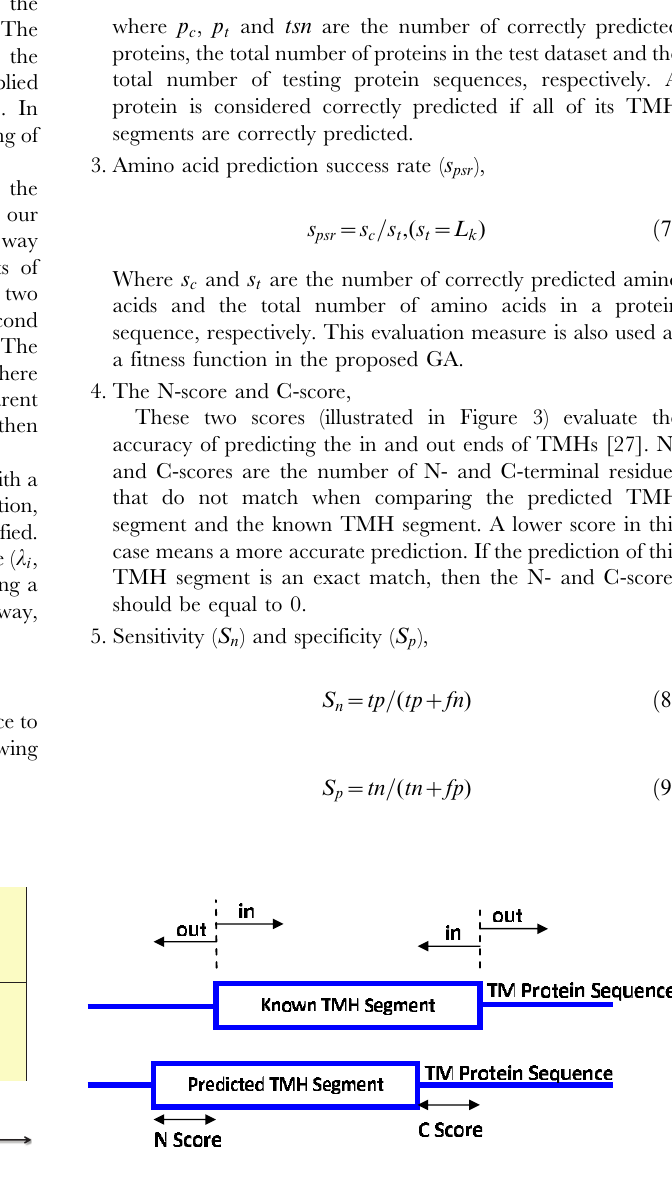
Figure 3. The N and C scores.